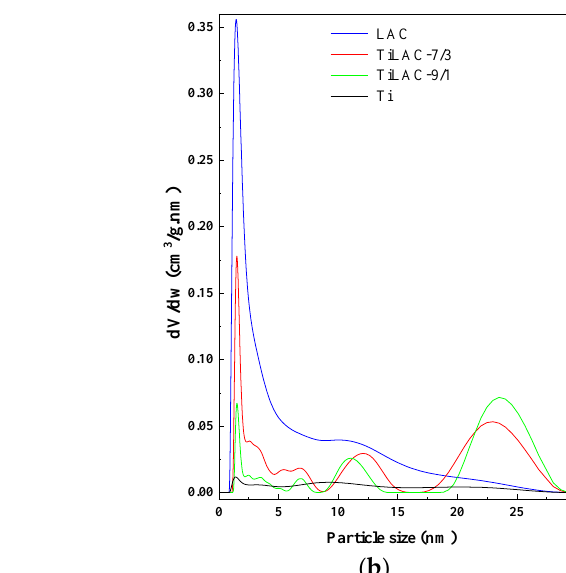
Table 1. Textural parameters for P25 TiO 2 , the prepared luffa activated carbon (LAC) and